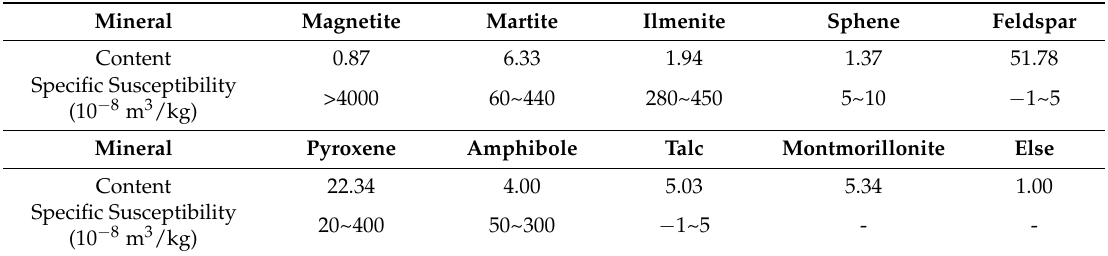
Table 2. Mineral composition of raw sample (wt %).